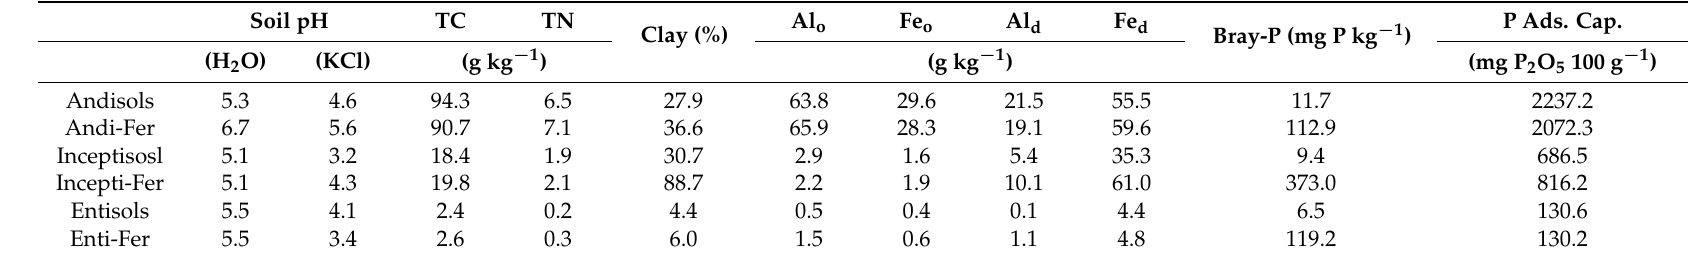
Table 1. Soil physico-chemical